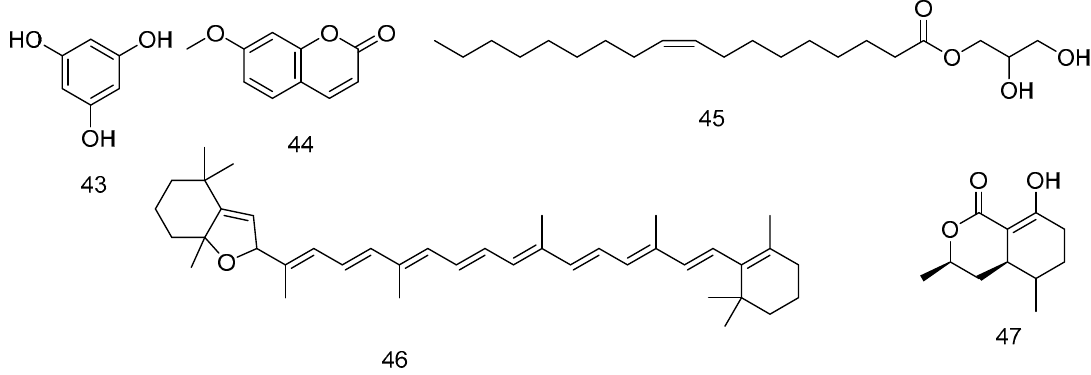
Figure 11. Compounds from 43 – 47 (phloroglucinol, coumarin, ester, carotene, and hydroxyramulosin).